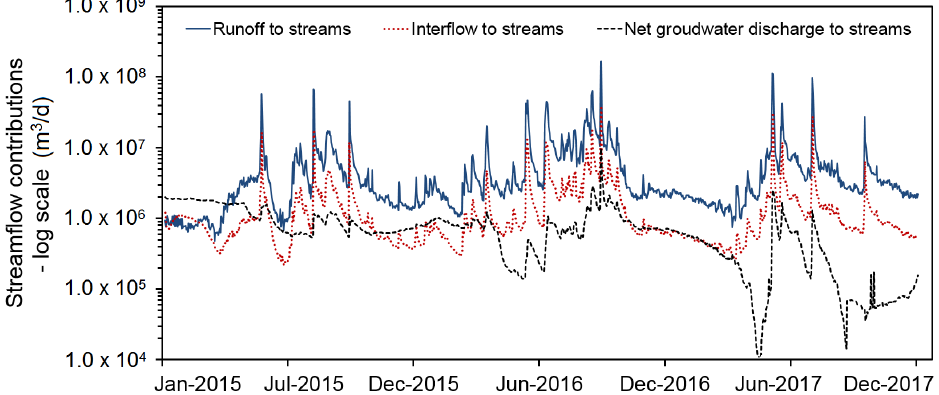
Figure 12. The time series of the volumetric flow rates that contribute to the streamflow.